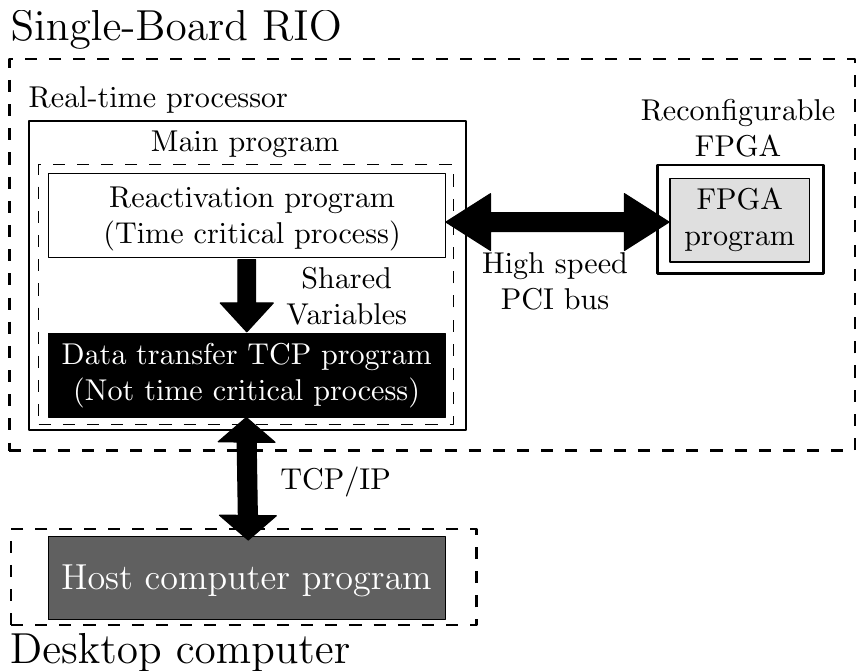
Figure 7. Software architecture diagram of the FC reactivation